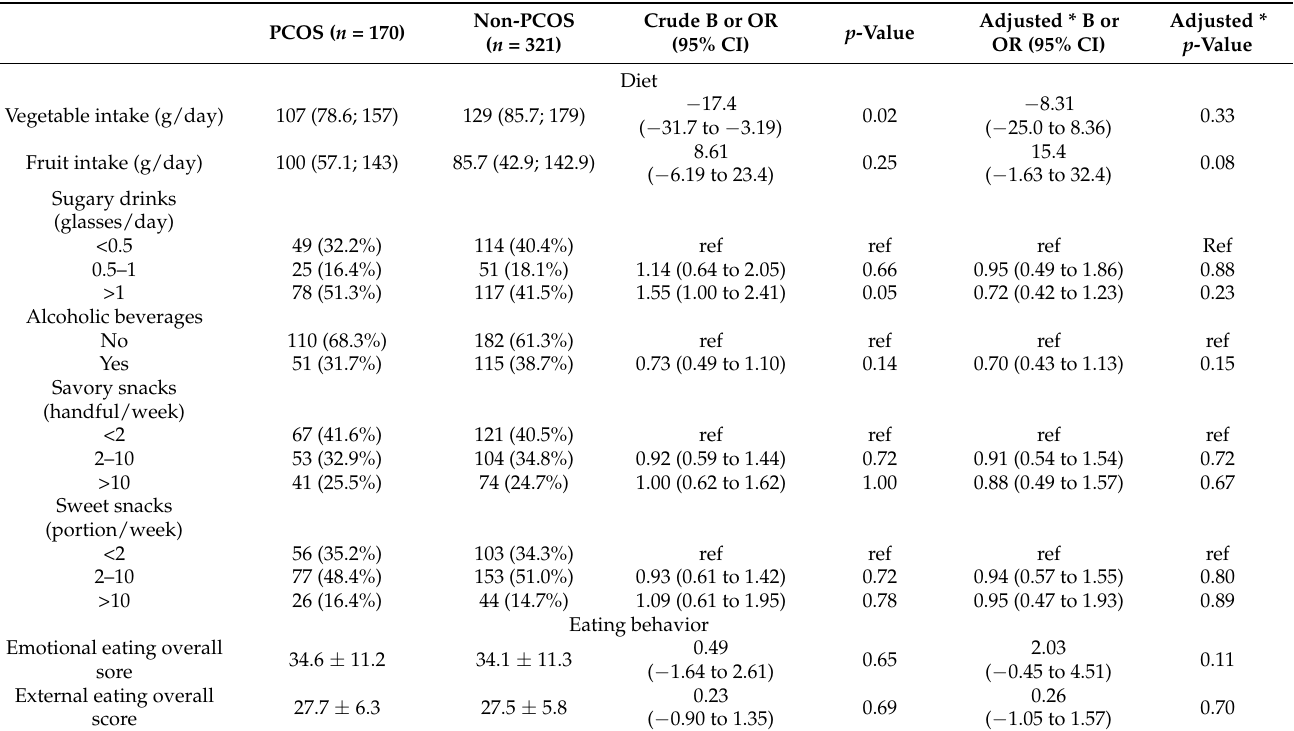
Table 2. Comparison of the diet, eating behavior, physical activity, and quality of life between the PCOS group and the non-PCOS